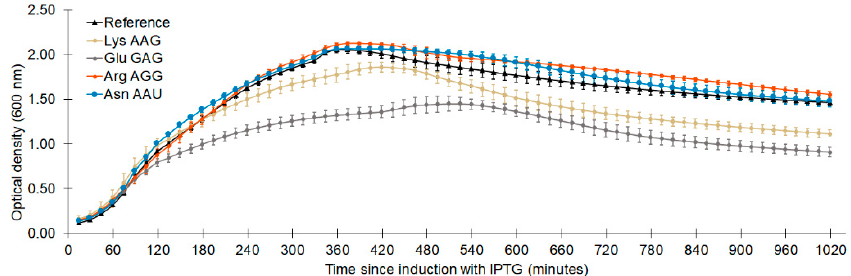
Figure 4. Optical density versus time since induction with IPTG profiles for sense codon reassigning systems expressing the TyrGen2 orthogonal pair. The reference system combined a non-fluorescent GFP reporter vector with an orthogonal translation machinery vector expressing an inactive version of the Pyl aaRS and the tRNA with a CUA anticodon.